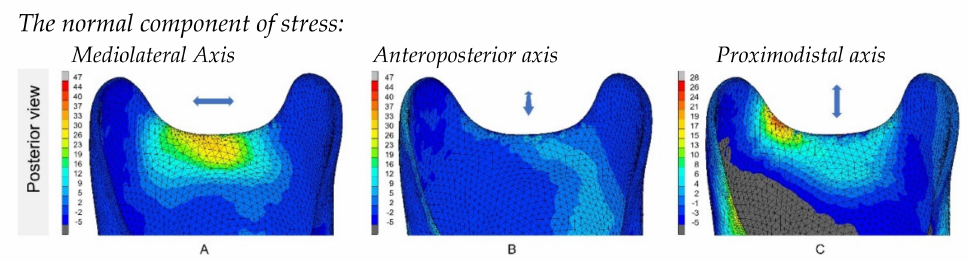
Figure 4. The three normal components of the stresses at the patella tendon area in a socket with a wall thickness of 4 mm, when subjected to the load case of ISO 10328 describing toe-off. ( A ) The normal components of stress in the mediolateral axis, ( B ) the anteroposterior axis en ( C ) the proximodistal axis. Note the change in the scale of the color bar in ( C ). As these stresses acted perpendicular to the printing direction, the scale was set to match the maximal tensile stress of the printed tough PLA in this direction.